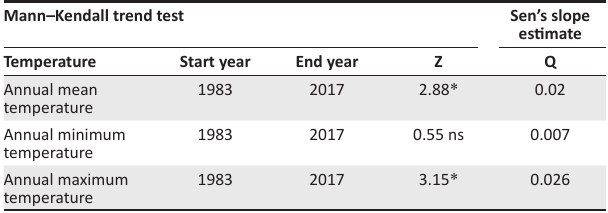
TABLE 9: Trend of maximum, minimum and mean temperature (° C ) in Harshin District (1983–2017).